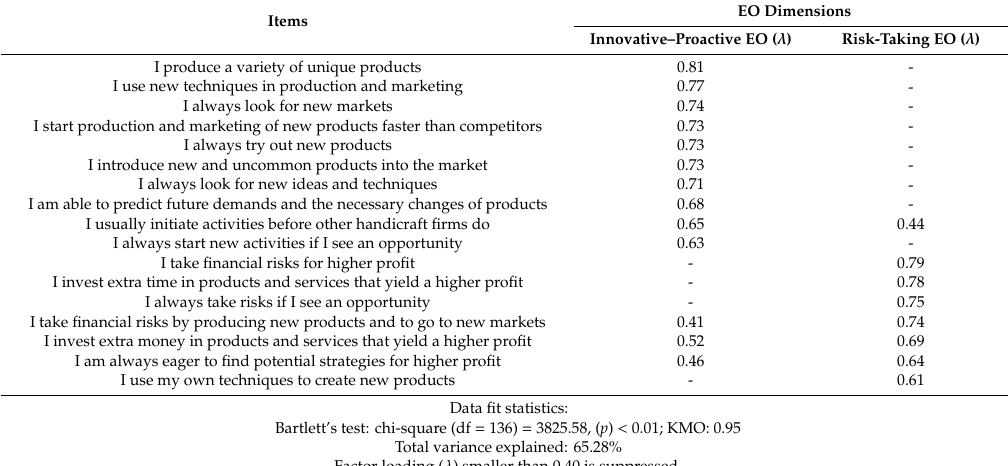
Table 2. Exploratory factor analysis for items of EO